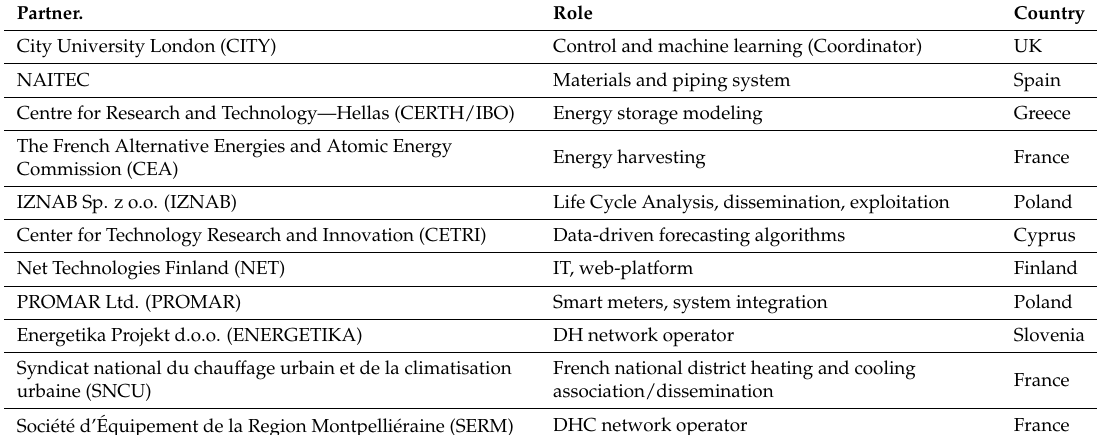
Table 1. The consortium of InDeal.